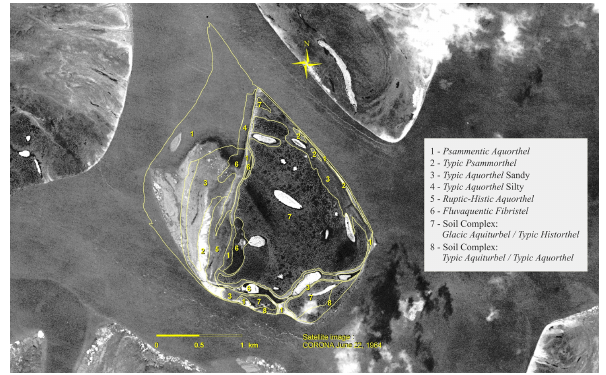
Figure 10. A soil map of Samoylov Island as a result of long-term soil research within this area of the Lena River Delta. Generated from data by Pfeiffer et al. (2000, 2002) (see Sanders et al., 2010). Soil classification according to the US Soil Taxonomy (Soil Survey Staff, 2010). The plotted coast line from July 1964 points out the high coastal dynamics within the beach and floodplain in the west- ern part of